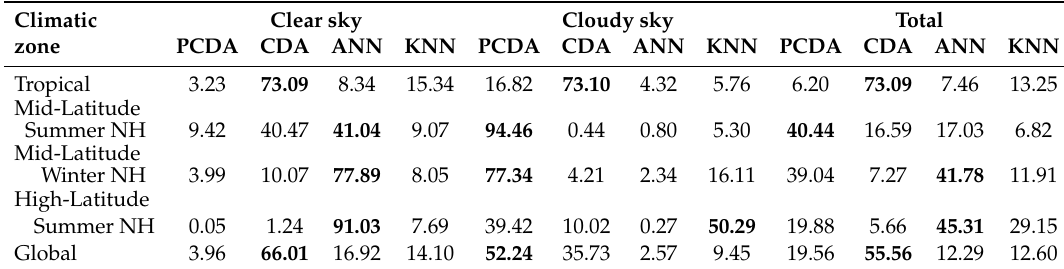
Table 16. Deviation of each classification method from the consensus expressed by other ones in the case classification is made separately for each climatic zone. Figures report the fraction of times a method disagrees with the other three ones that agree on the sky status. The higher the figure, the higher deviation from the consensus. Methods showing the highest disagreement for each climatic zone and sky conditions are indicated as